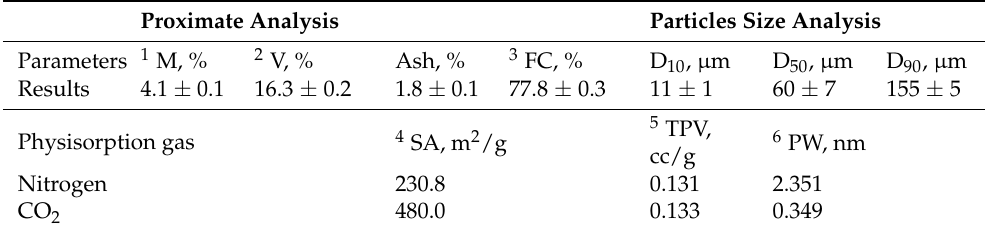
Table 2. Characteristics of beechwood biochar used for PLA reinforcement.